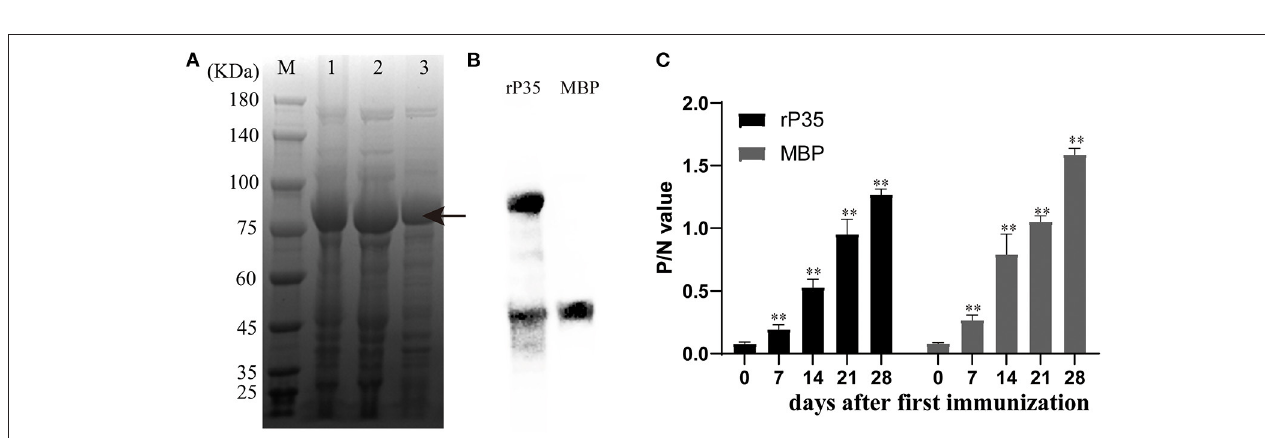
FIGURE 2 | Expression and preparation of polyantiserum of rP35. (A) Coomassie Blue staining of the Mycoplasma synoviae (MS) protein expressed in Escherichia coli BL21 (DE3) and run on 10% polyacrylamide gels. Lane M: standard protein marker. Lane 1: total cell extract of E. coli BL21 (DE3). Lane 2: soluble fraction of the total bacterial extract after induction. Lane 3: protein purified by nickel column. The two bands in lane 3 may be the fractured recombinant proteins during purification. (B) Western blotting assay to verify the successful expression of recombinant protein. The right lane is MBP protein and the left lane is recombinant protein rP35. The primary antibody used was monoclonal antibody of anti-MBP tag. (C) Production of polyantiserum of rP35. rP35- and MBP-specific IgG responses induced in specific pathogen-free (SPF) chickens immunized with protein (400 µ g) performed using blood samples collected every 7 days for 28 days. **means there were significant differences; Arrow means the target protein we